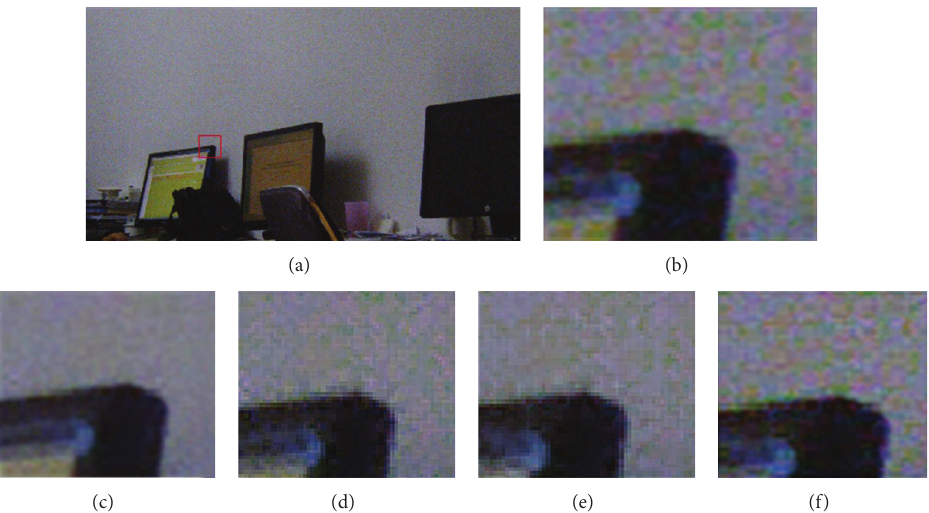
Figure 7: The denoising results of different guiding signals on the actual bayer image: (a) full original image, (b) an enlarged patch of (a), (c) denoised by green channel guidance, (d) denoised by red channel guidance, (e) denoised by blue channel guidance, and (f) denoised by each of the channels guiding themselves.